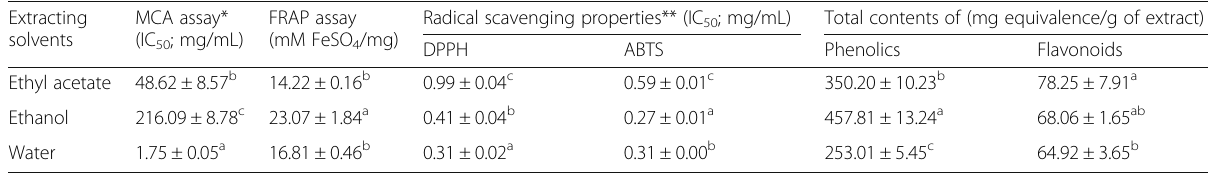
Table 3 Metal chelating activity (MCA), ferric reducing-antioxidant power (FRAP), free radical scavenging capacities, total phenolic content, and total flavonoid content of different extracts of Jatu-Phala-Tiga Extracting solvents